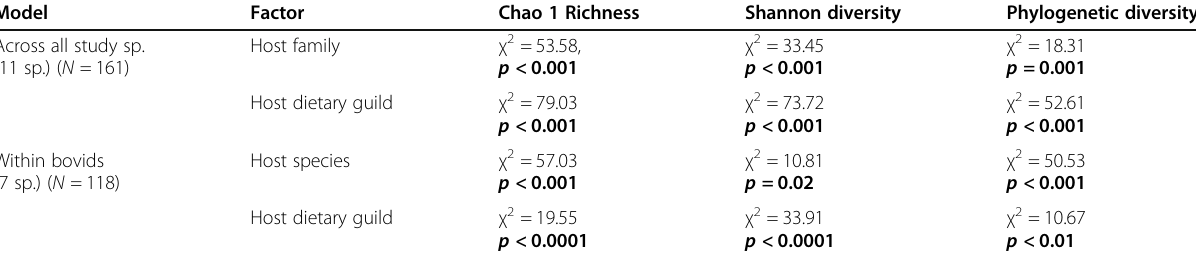
Table 4 Microbiota richness, evenness, and phylogenetic diversity vary with host taxonomy and dietary guild Model